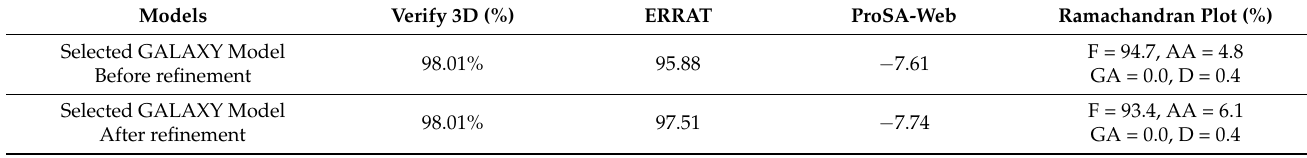
Table 1. Validation scores of top Galaxy Model 4, before and after refinement. Verify 3D (based on percentage of the residues had an averaged 3D–1D score ≥ 0.2), ERRAT (based on overall quality factor), ProSA-WEB (based on Z-score), and Ramachandran Plot (F: Favored, AA: additionally allowed, GA: generously allowed, D: disallowed). The best model of refinement with the highest score was selected for the next steps.